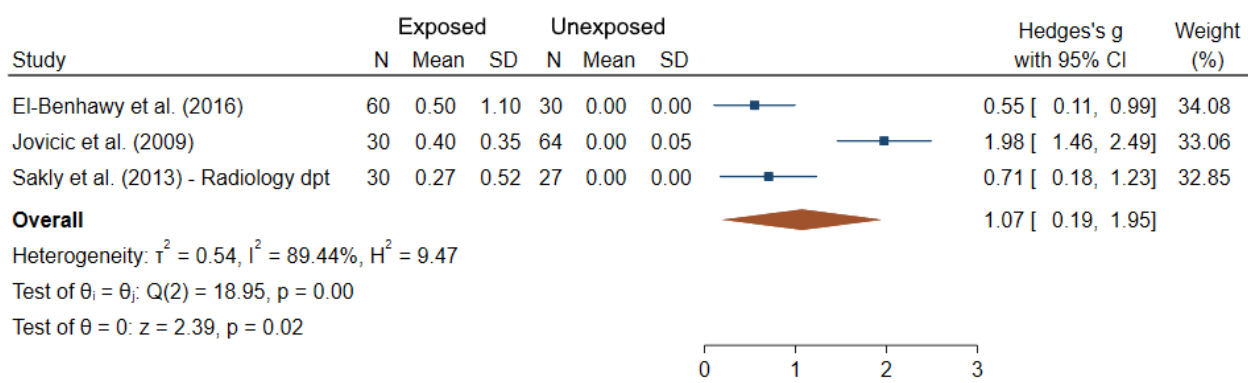
Figure 3. Forest plot of mean differences in fraction of cells with CA between IR exposed and unexposed workers. The blue squares represent the differences in standardized means between IR-exposed and non-exposed workers for each study individually (with their associated blue bar corresponding to the confidence interval of each mean), while the brown diamond below corresponds to the estimated overall standardized mean difference (placed in the center of the diamond, with the bounds of the confidence interval being at the extreme points of the diamond).